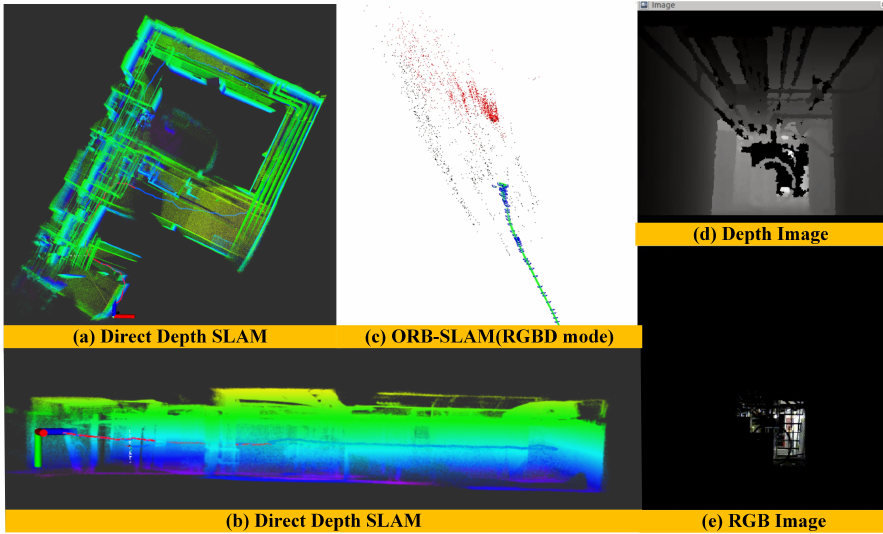
Figure 13. The performance of mapping results in a dark environment after applying direct depth SLAM ( a ) and ORB-SLAM ( c ) methods,